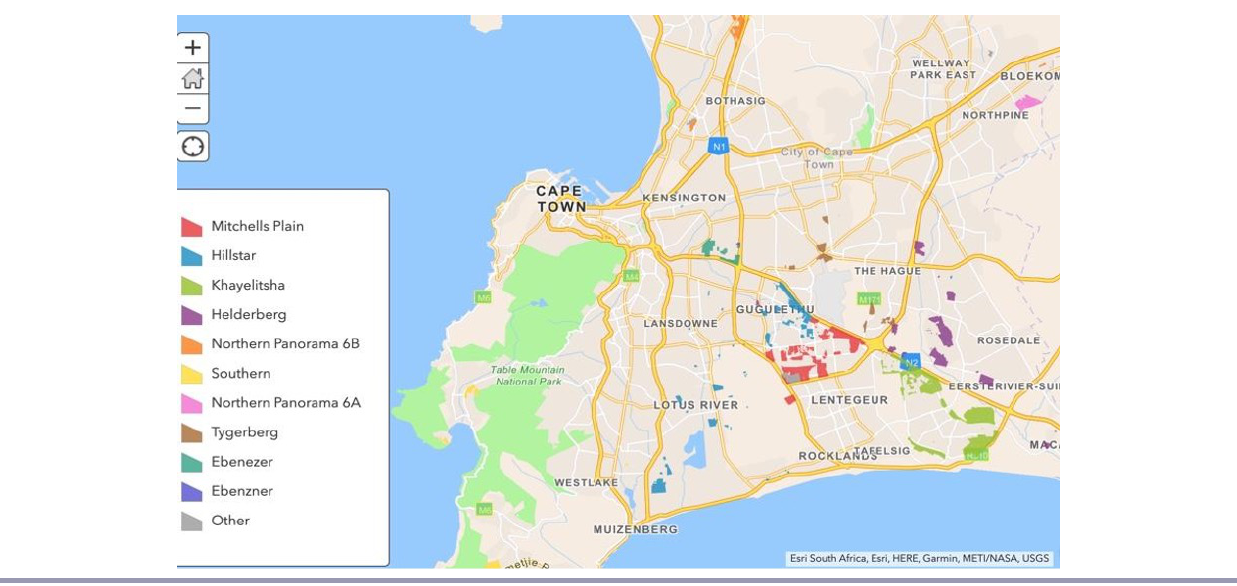
Fig. 1. Most of the informal settlements in Cape Town, South Africa are located in the Cape Flats, east of the city center. Map overlay data source: City of Cape Town GIS Data - Creative Commons